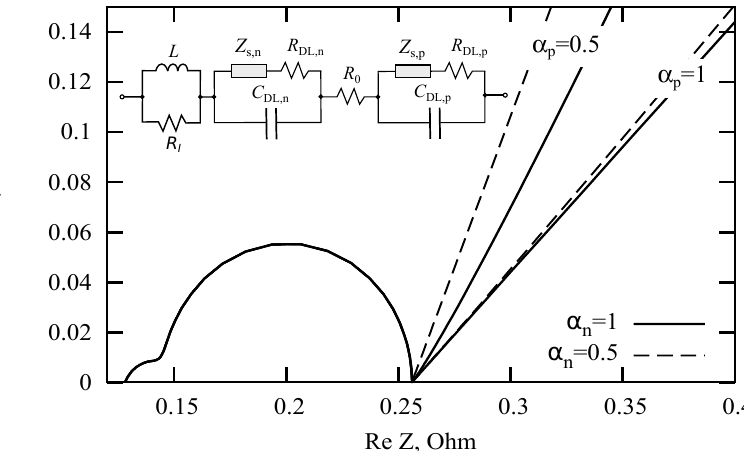
Figure 7. The change in slope of the rectilinear part of the Nyquist diagram with variations in subdiffusion